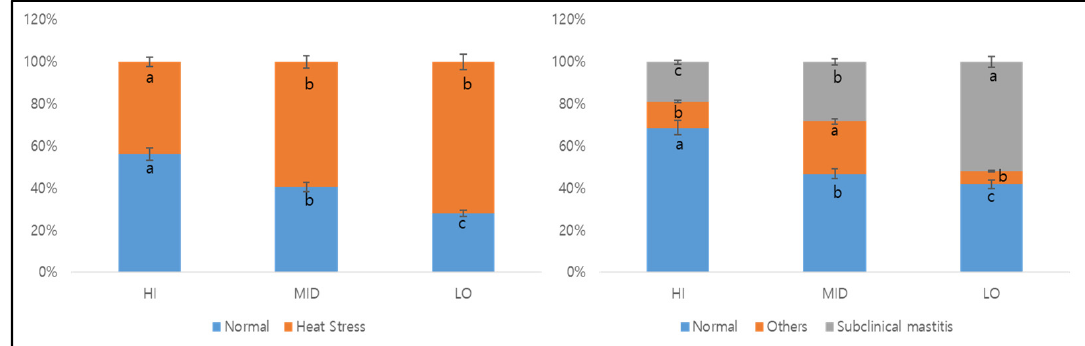
Figure 4. Percentage detection of normal, heat stress, and subclinical mastitis using the data-mining hub with the different number of parameters: HI (21 parameters), MID (13 parameters), and LO (8 parameters).